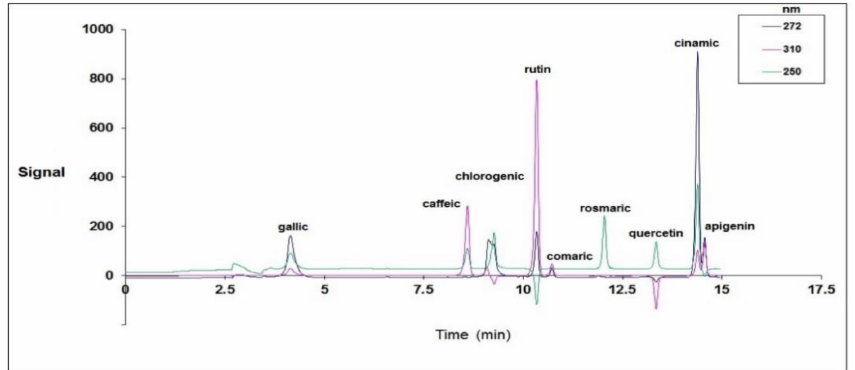
Figure 2. The standard graph of the phenolic compounds in the HPLC